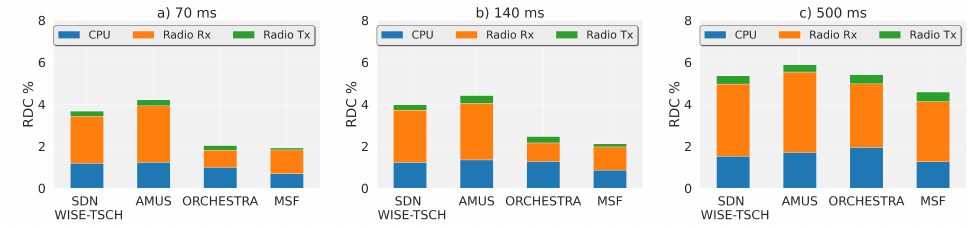
Figure 5. Radio duty cycle for each scheduler with different packet